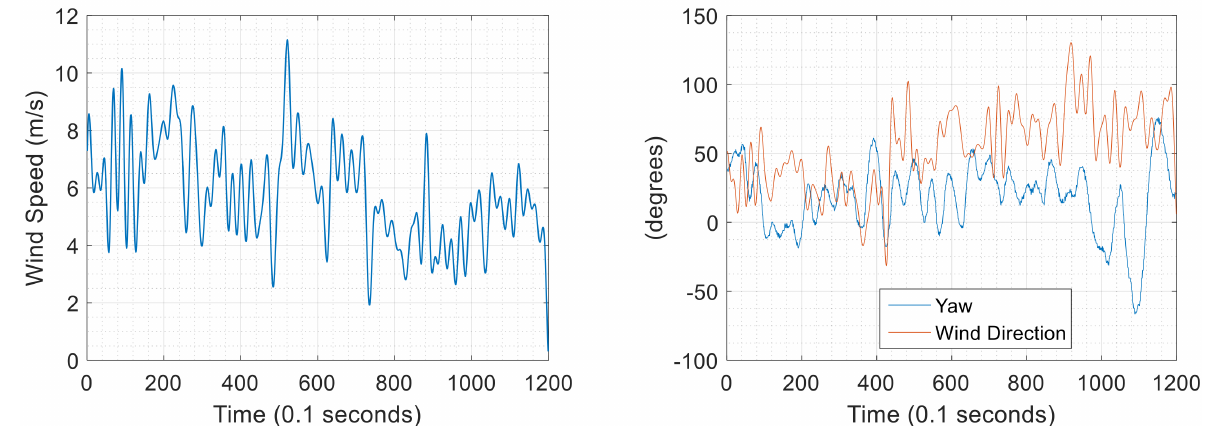
Figure 10. Data measured for a period of 2 minutes with 10 Hz sampling frequency, ( left graph) Wind speed measured at hub height and 6 meters next to the micro wind turbine, ( right graph) Yaw angle of the micro wind turbine and wind direction (0 ◦ is North and 90 ◦ is East) for WindChallenge